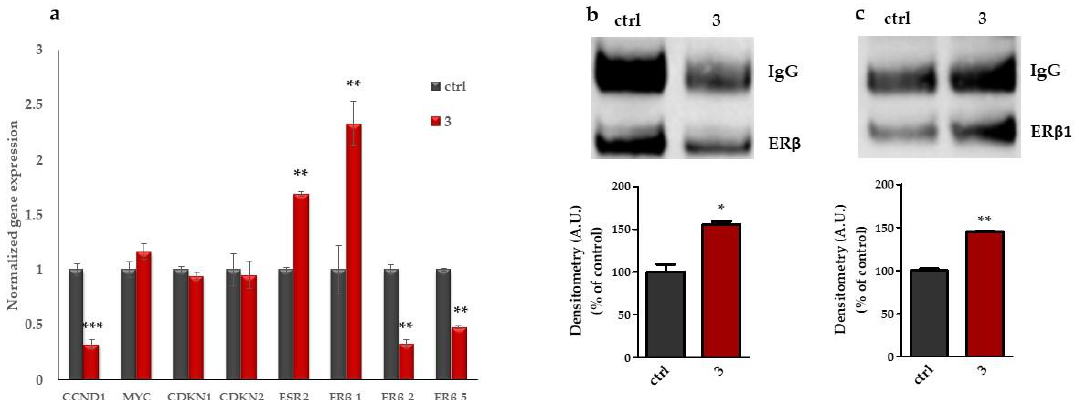
Figure 7. Compound 3 modifies ESR2 isoform expression in IGROV1: ( a ) gene expression for CCND1, MYC, CDKN1A, CDKN2A, ESR2, ER β 1 , β 2, and β 5 analyzed by RT-PCR after 24 h of treatment; and ( b , c ) immunoprecipitation and Western blot analysis of ER β and β 1 (top). Cell lysates from control and IGROV1 treated with 3 for 48 h were immunoprecipitated with anti ER β or β 1 antibodies; and (bottom) relative quantification of ER β and β 1. Densitometry arbitrary units (A.U.) were normalized by IgG. Results are given as means ± SD of three independent experiments and are compared to controls, taken as 100%. * p < 0.05, ** p <